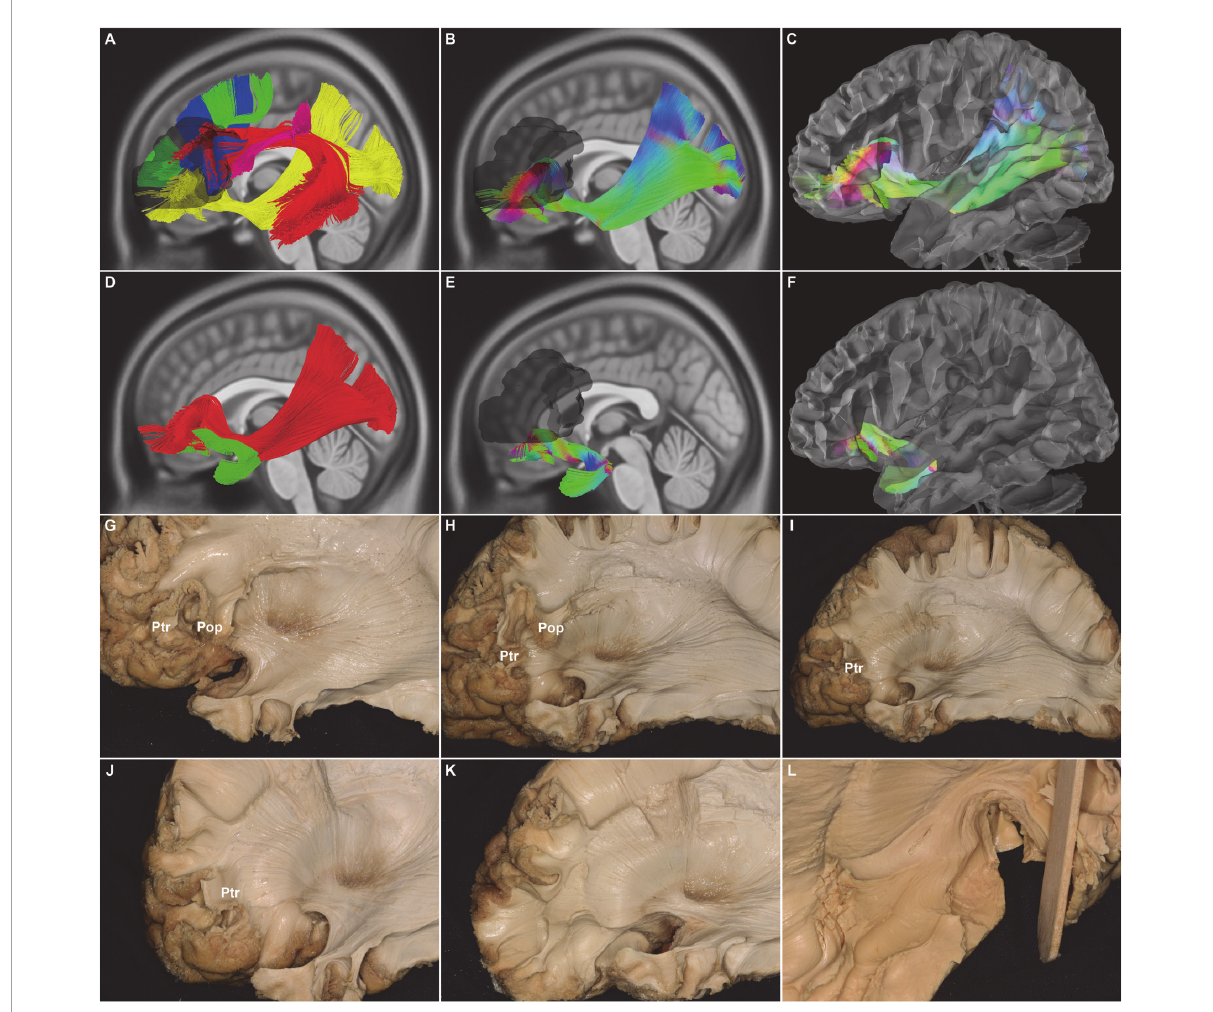
FIGURE2 In vivo fiber tractography of the UF and the subdivision of the IFOF (HCP-842). (A) Five fiber tracts were identified around the Broca’s region (shadow area): the IFOF (yellow), AF (red), SLF-III (purple), FAT (blue), and FLF (green). (B,C,G,H) In vivo fiber tractography and fiber microdissection of the IFOF. The subdivision of the IFOF originated from the inferior frontal gyrus (i.e., Pop, Ptr, and Por), passed through in the depth of temporal lobe and insula, and finally projected to the occipital cortex, temporobasal areas, and superior parietal lobe. (E,F,H,J, L) In vivo fiber tractography and fiber microdissection of the UF. The UF connected the frontal and anterior temporal lobes as a “hook-shaped” fascicle. No fibers that connected with the Broca’s region were identified. (D,H,I,J) Spatial relationship of the IFOF and UF. IFOF was just above and medial to the UF at the level of the external/extreme capsule. (G,H,I,J,K) Step by step of the fiber microdissection of the IFOF frontal terminations. IFOF, inferior fronto-occipital fasciculus; UF, uncinate fasciculus; AF, arcuate fascicle; SLF-III, superior longitudinal fasciculus III; FAT, frontal aslant tract; FLF, frontal longitudinal fasciculi; IFG, inferior frontal gyrus; Pop, pars opercularis; Ptr, pars triangularis; Por, pars orbitalis; shadow area, Broca’s